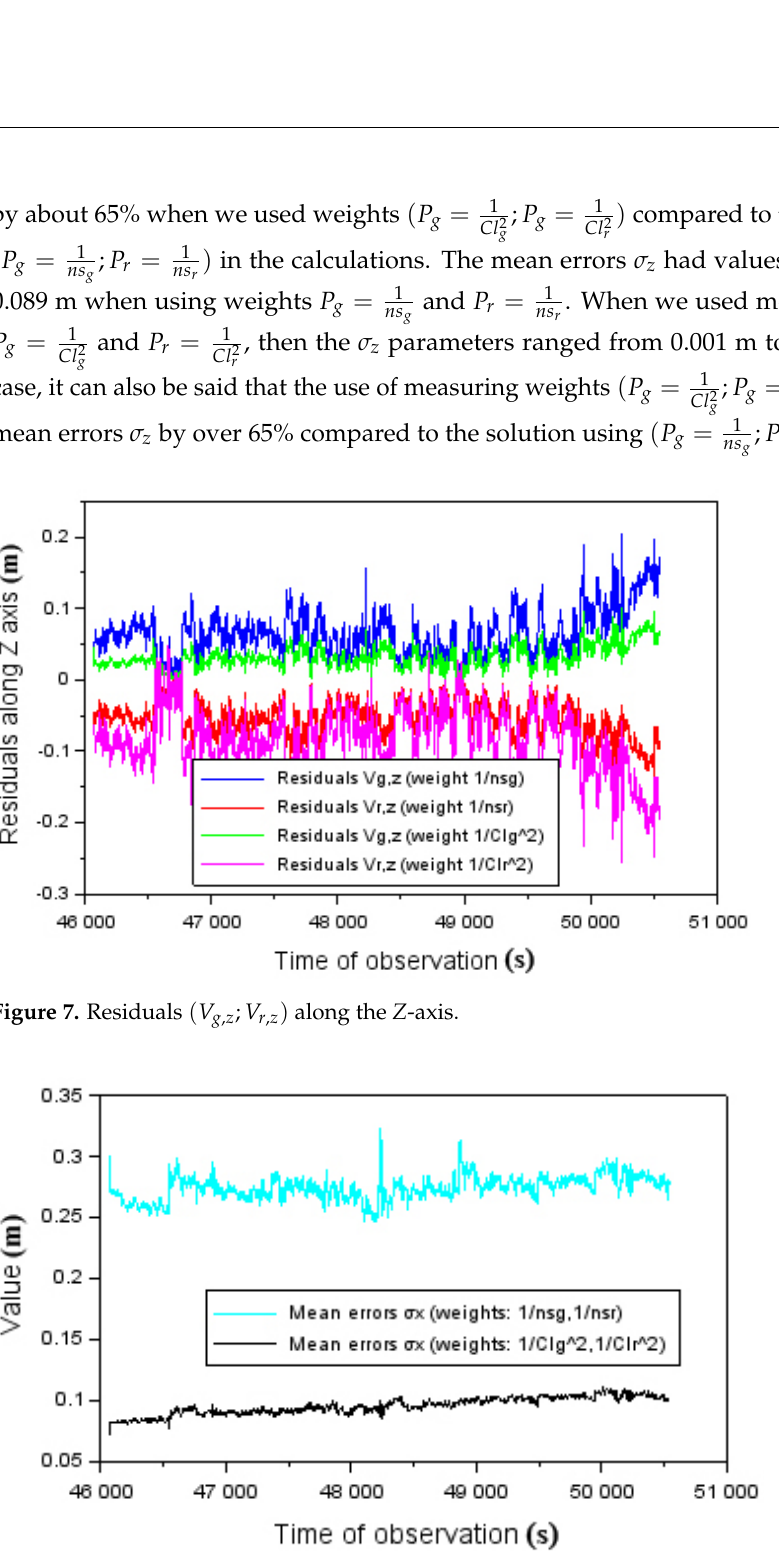
Figure 8. Mean errors σ x along the X